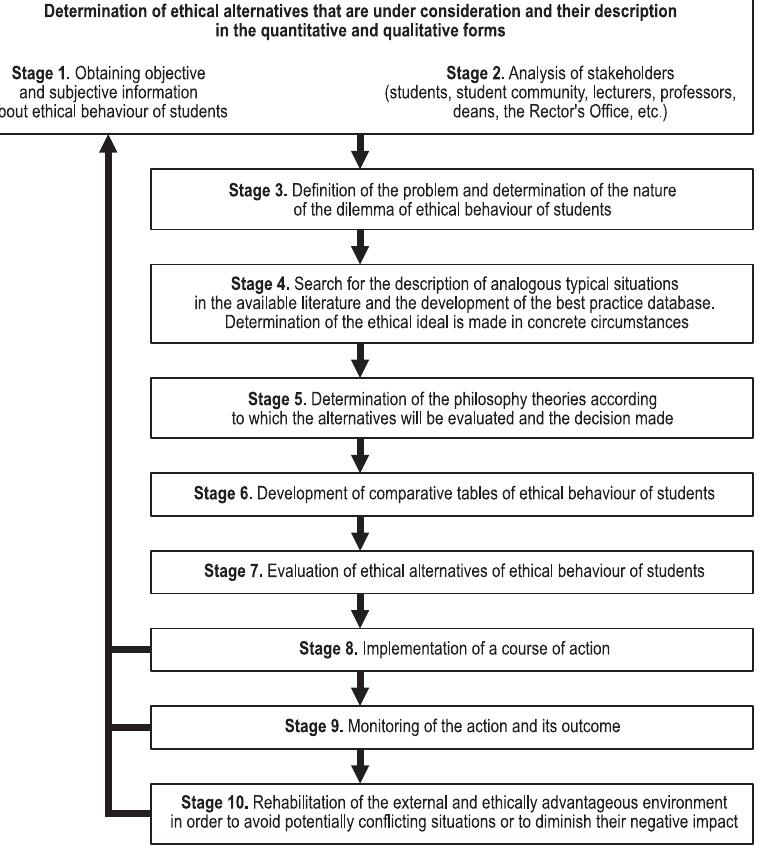
Fig. 1. Main stages of the developed Web-based Model of Multiple Criteria Ethical Decision-Making for Ethical Behaviour of Students and their relation to